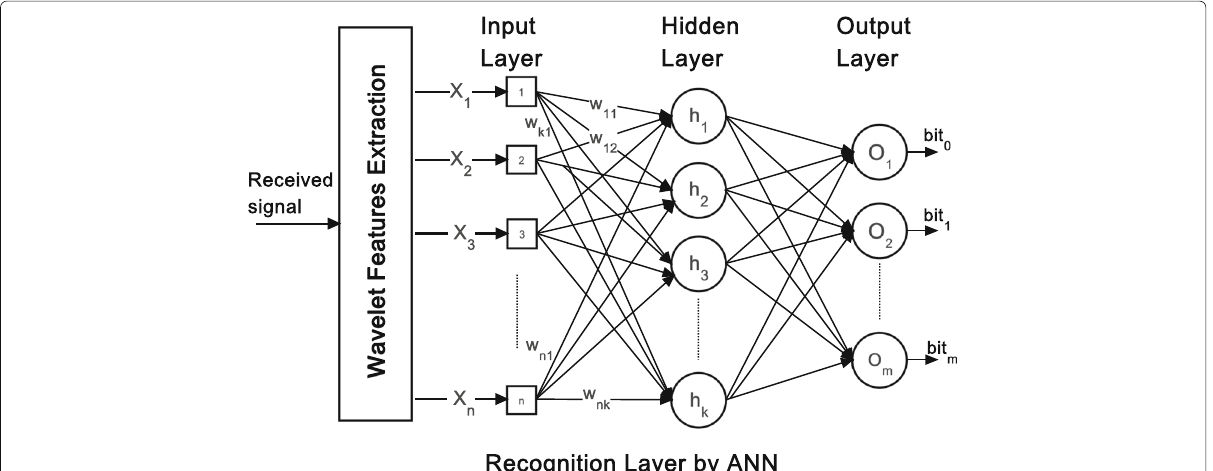
Fig. 5 Feed-forward ANN (FFNN) with one hidden layer and an output layer. The extracted features are fed into ANN with n input nodes, and k and m are the number of hidden and output neurons, respectively. The output bits are the bits that were recognized by the